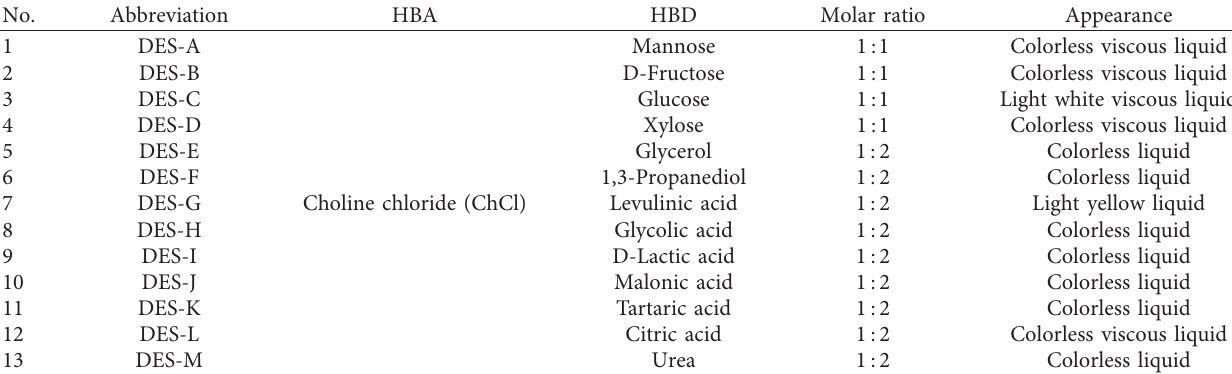
Figure 2: HPLC chromatograms of Premna fulva Craib (a) and the five reference compounds (b). Table 1: List of the choline chloride-based DESs synthesized in this